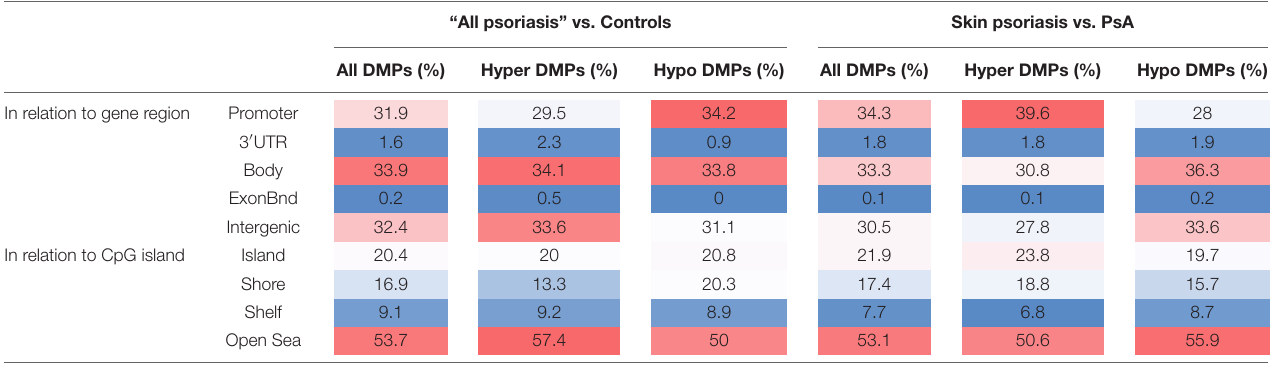
TABLE 3 | Functional genomic distribution of DMPs in CD8 + T cells from psoriasis, psoriatic arthritis patients, and controls. “All psoriasis” vs. Controls Skin psoriasis vs. PsA